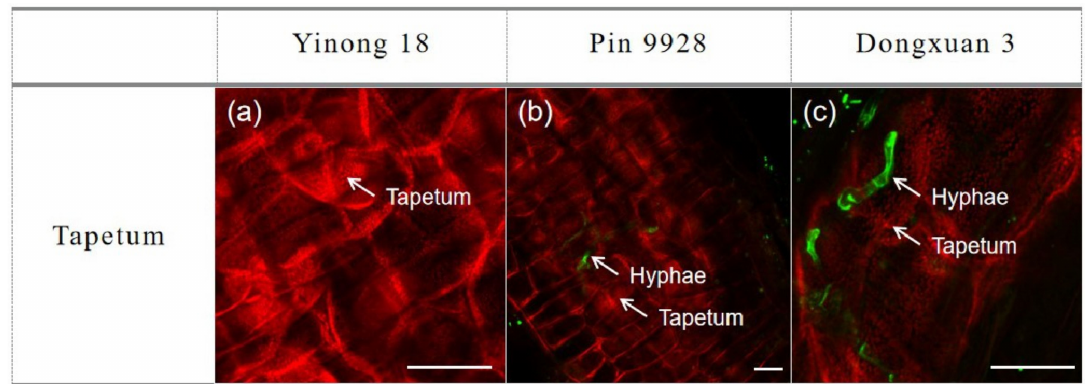
Figure 4. Examination of fungal hyphae in tapetum cells of anther in resistant (Yinong 18), moderately resistant (Pin 9928) and susceptible (Dongxuan 3) wheat cultivars. ( a ) examination of fungal hyphae in tapetum cells of resistant cultivar; ( b ) examination of fungal hyphae in tapetum cells of moderately resistant cultivar; ( c ) examination of fungal hyphae in tapetum cells of susceptible cultivar. Scale bar = 25 µ m.